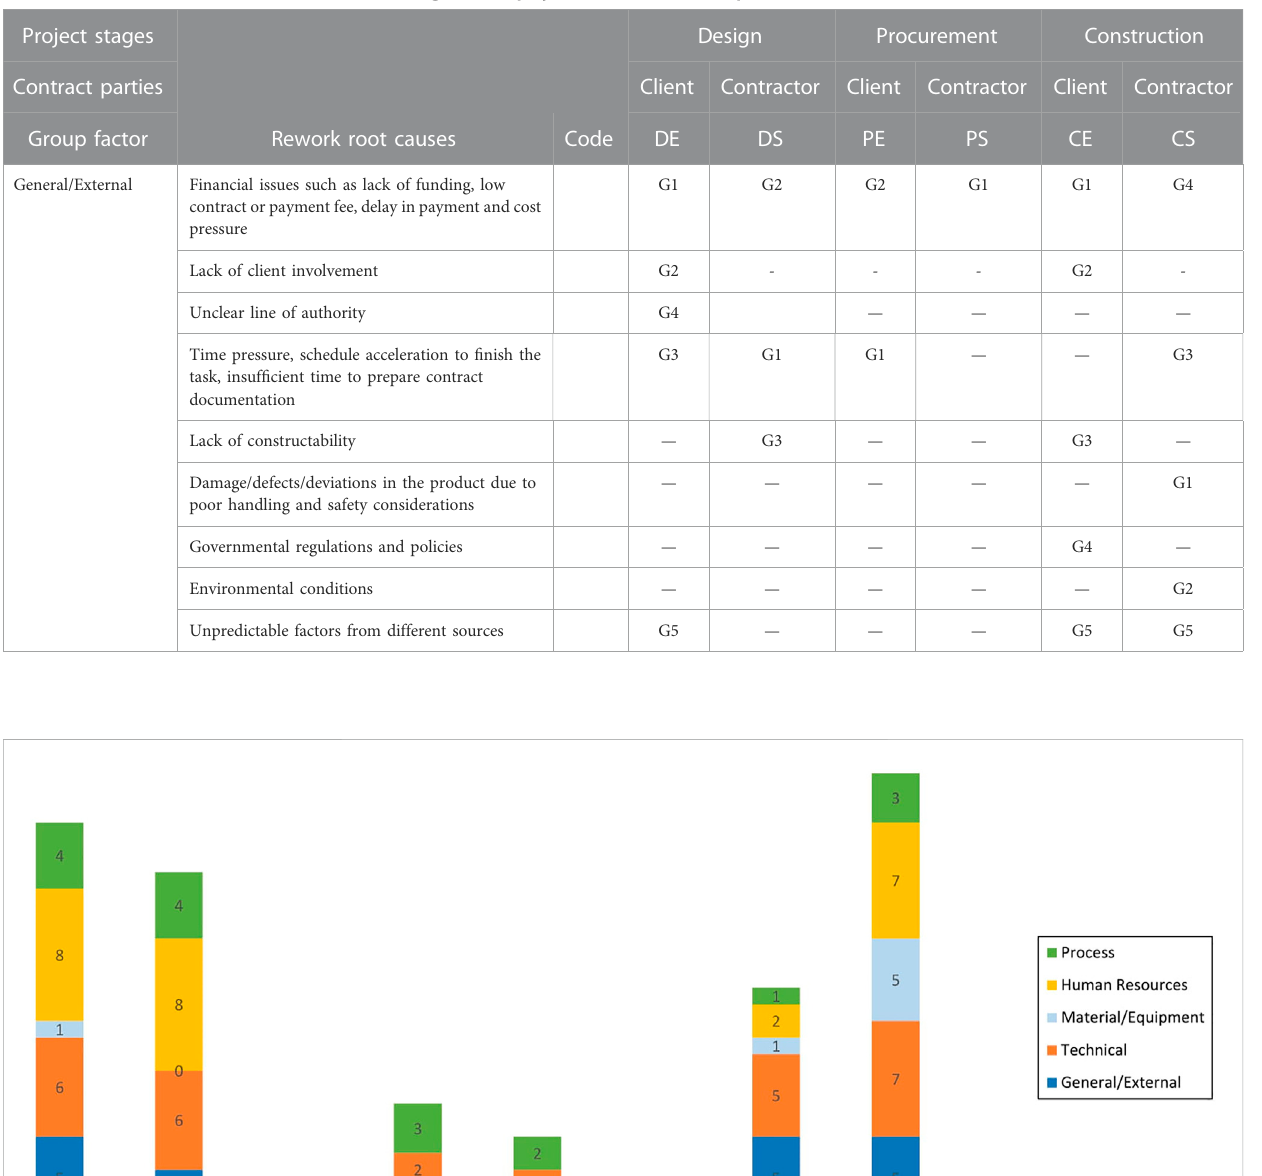
Table 8. This table comprises a list of 37 collected rework causes which are categorized into fi ve primary constructs. The process related factor is involved with the projects ’ main activities. The human resources related factor deals with the human attributes. The material/ equipment related factor supplies the project requirement. The